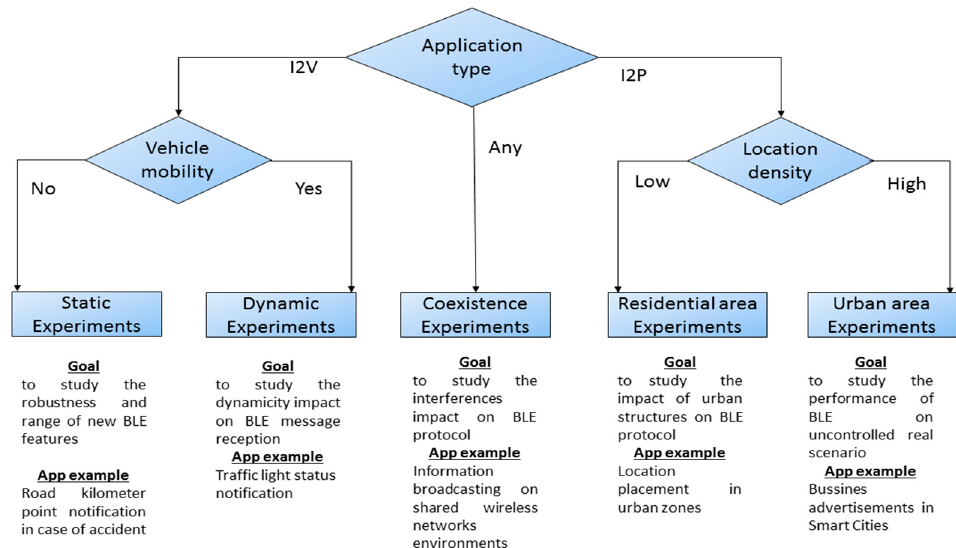
Figure 5. Experiment goals based on application types.